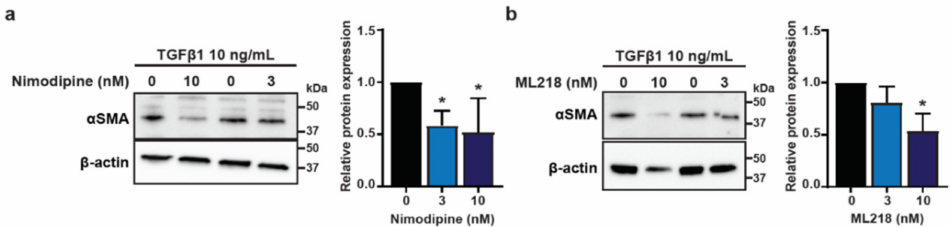
Figure 5. Pharmacological suppression of TGF β 1-induced α SMA expression in HMF3S cells. α SMA protein expression was assessed after treatment with ( a ) nimodipine, and ( b ) ML218. Representative immunoblot and densitometry data showed significant downregulation of α SMA protein with 3 and 10 nM nimodipine and with 10 nM ML218. Data are represented as mean ± SD from four independent experiments; * p < 0.05 from post-hoc Dunnett’s multiple comparison test after one-way ANOVA revealed significant effect of